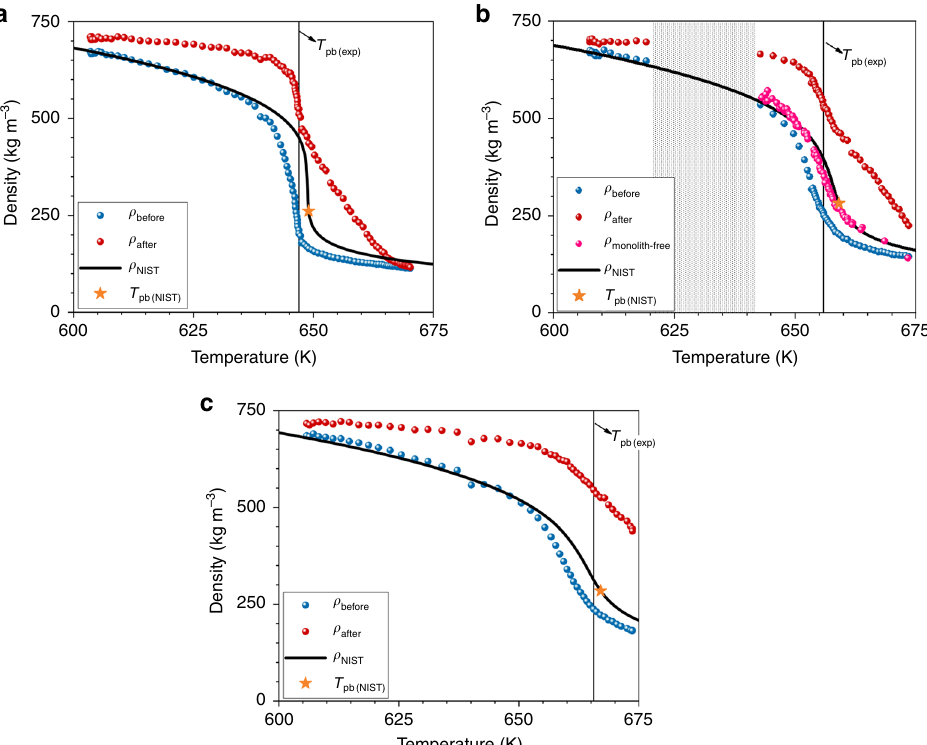
Fig. 6 Temperature variation of water density outside monolith. It presents density variations recorded before ( ρ before ) and after ( ρ after ) the monolith at a 225 bar, b 250 bar, and c 270 bar; the NIST 13 reference values for bulk water density are included for comparison; the pseudo -boiling temperature T pb(exp) determined experimentally is indicated by the solid line; the orange symbol indicates the theoretical values of the temperatures corresponding to the pseudo -boiling line; for the 250 isobar the density variation with temperature for the monolith-free case are also presented ( ρ provided as a Source Data fi le